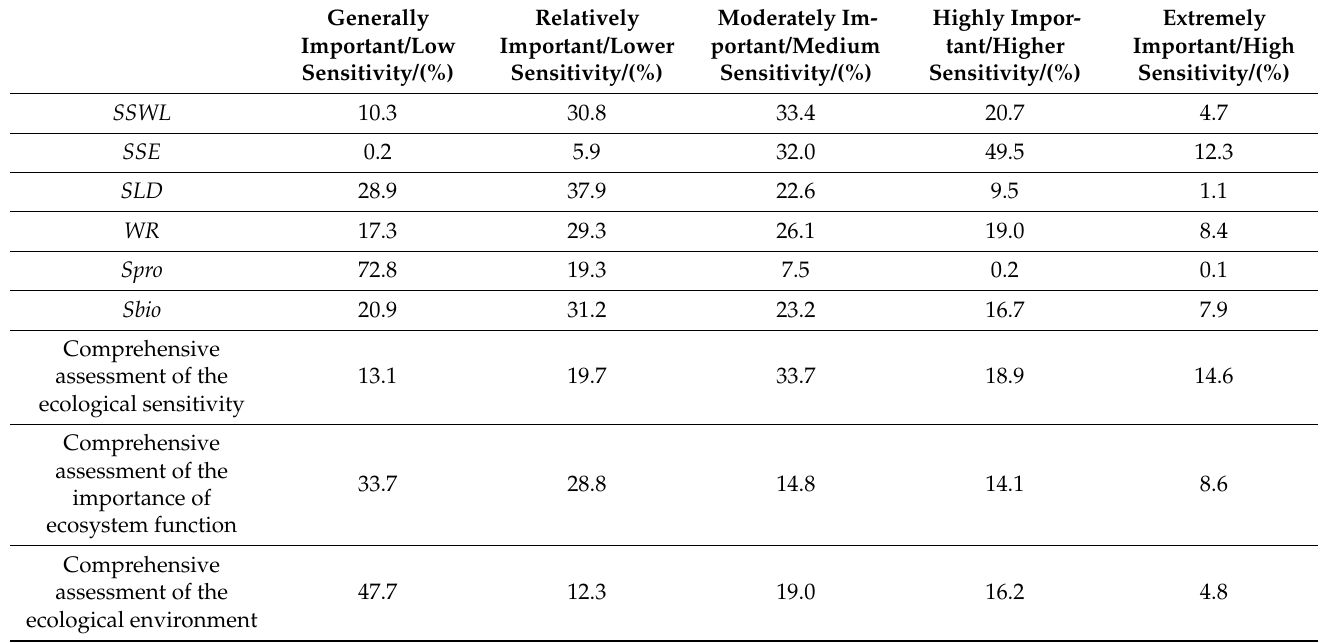
Table 4. Area statistics of eco-environmental assessment factors in the Minjiang River